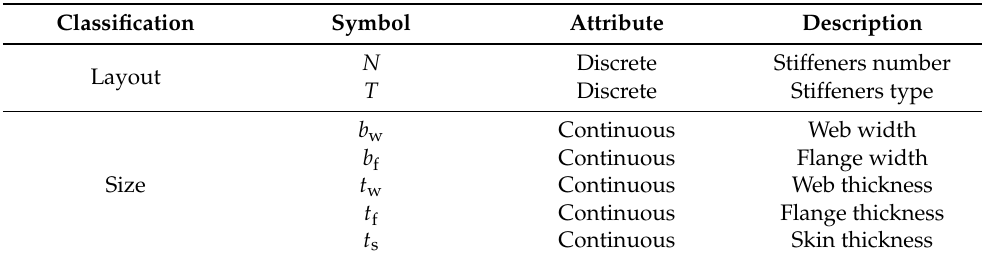
Table 1. Description of design